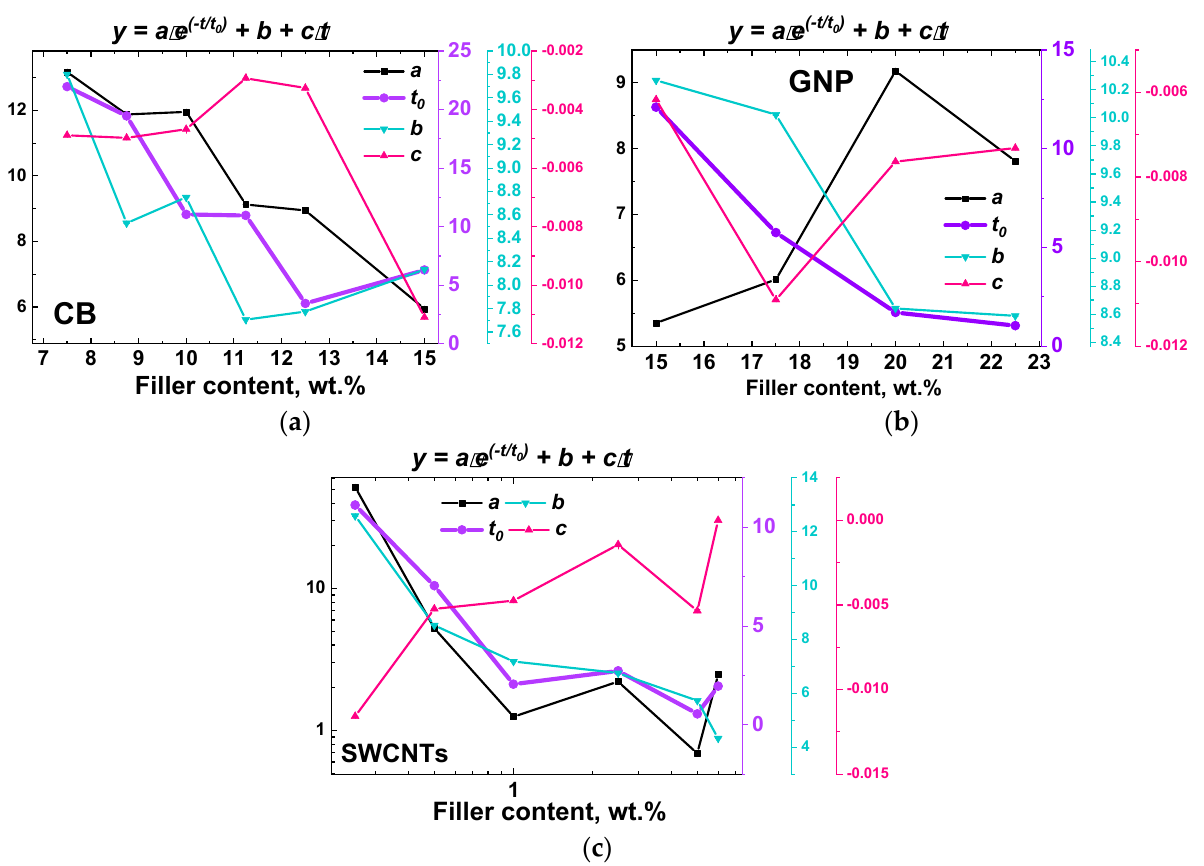
Figure 8. Dependences of the parameters of the equation (4) for the conductivity-time curves (Figure 7) on the filler content for the PP/CB ( a ), PP/GnPs ( b ) and PP/SWCNTs ( c ) composites.